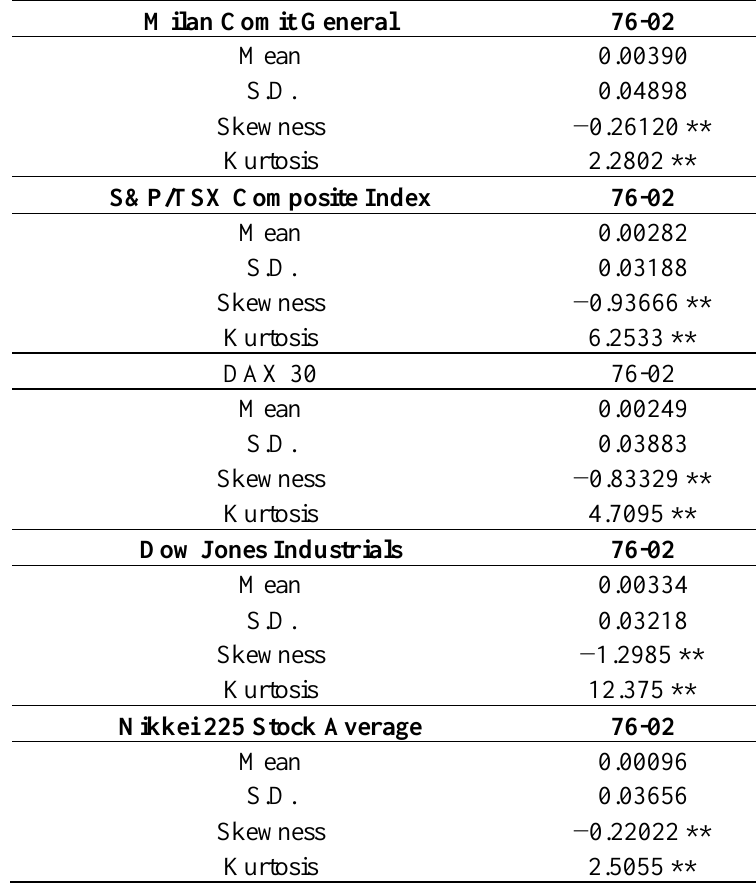
Table 1. Summary statistics for ten-day